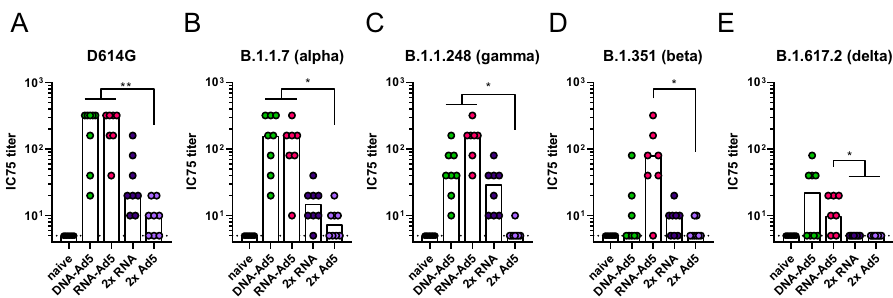
Fig. 6 Neutralization of SARS-CoV-2 variants. C57BL/6 mice were vaccinated according to Fig. 5A. BAL samples were analysed by pseudotype neutralization assays for the neutralization of different SARS-CoV-2 variants ( A – E ). Data points were shown for individual animals and bars represent group medians; RNA-Ad5 n = 7, other groups n = 8 (out of two independent experiments). The dashed line indicates the lower limit of detection. Data were analysed by Kruskal – Wallis test (one-way ANOVA) followed by Dunn ’ s multiple comparison. Statistically signi fi cant differences are indicated only among the different vaccine groups; p values indicate signi fi cant differences (* p < 0.05; ** p < 0.005; *** p < 0.0005; **** p <